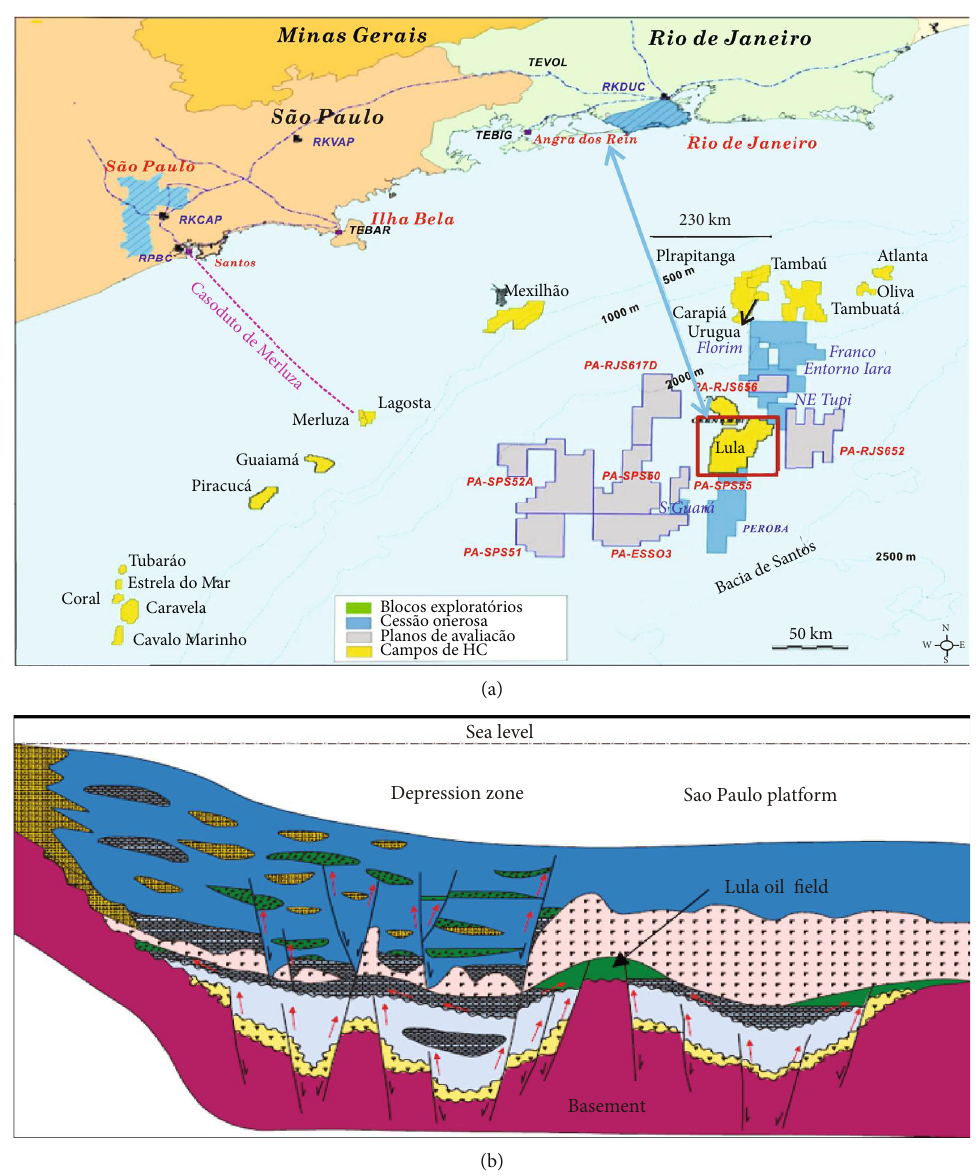
Figure 3: (a) Location map of the Lula oil fi eld, Santos Basin, Brazil. (b) Schematic diagram of the geological environment in the Lula oil fi